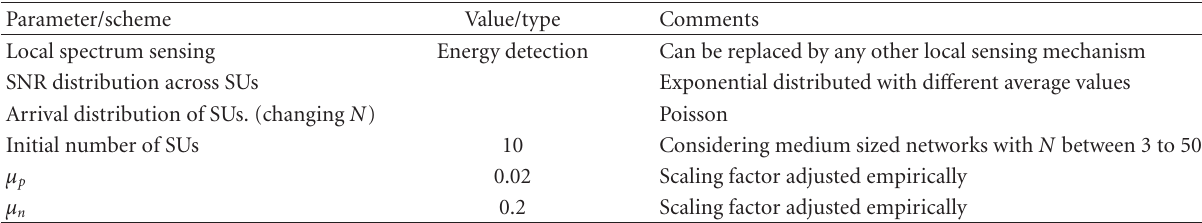
Table 2: List of parameters for simulation.